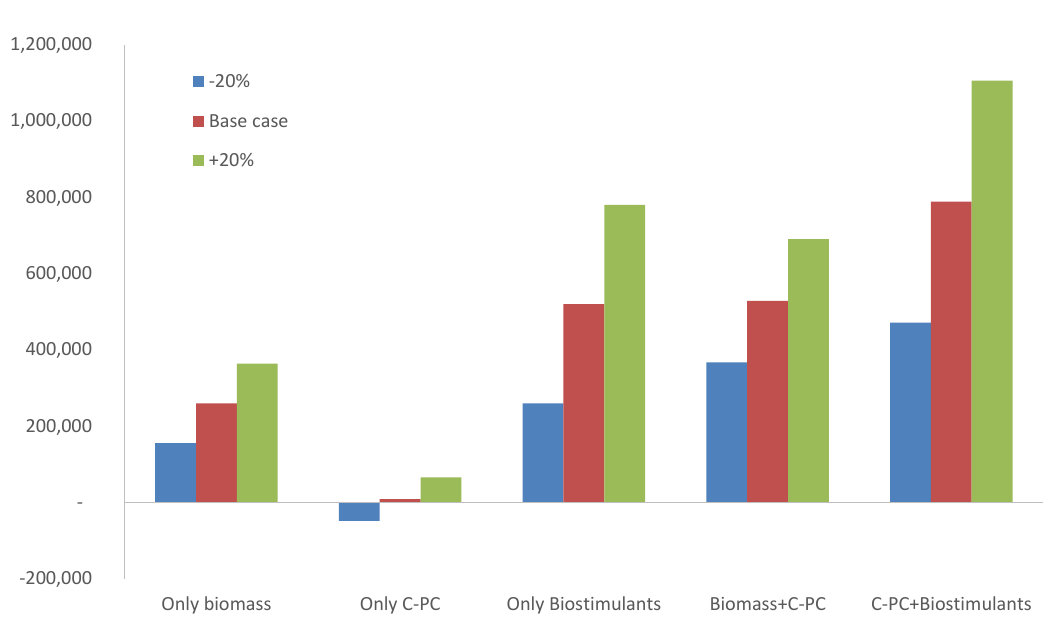
Figure 7. Economic analysis of different scenarios for a 1-ha facility producing Oscillatoria sp. for different purposes (biomass, C-PC extracts used as a food colourant, and biostimulants). Table 3. Values for the base case study of a 1-ha facility producing Oscillatoria sp. biomass in open reactors for the production of biomass, C-PC extracts, and/or biostimulants.